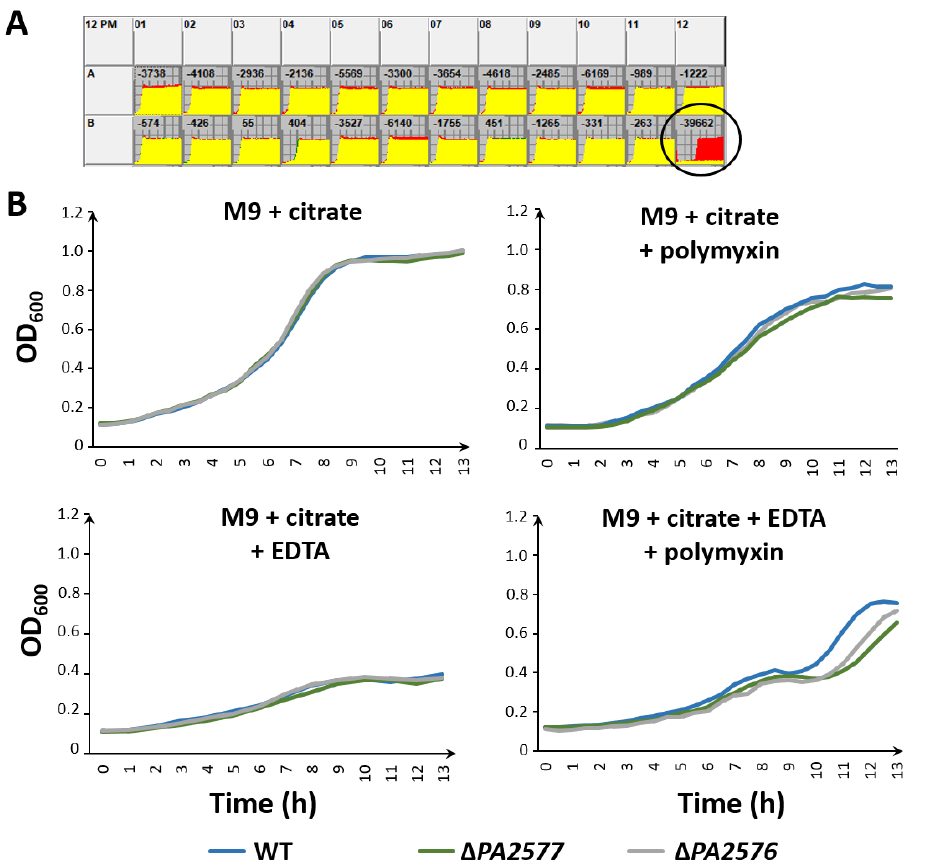
Figure 6. ( A ) BIOLOG phenotype microarray results of ∆ PA2576 strain vs. WT strain on plate PM12B. B12 location corresponding to conditions with the highest concentration of polymyxin B is marked. ( B ) Growth curves of the P. aeruginosa PAO1161 ∆ PA2577 , ∆ PA2576 mutants and WT strain in M9 supplemented with citrate, with the addition of polymyxin B (1 µ g/mL) or/and EDTA (0.5 mM) at 37 ◦ C. Data represent mean OD 600 from three independent